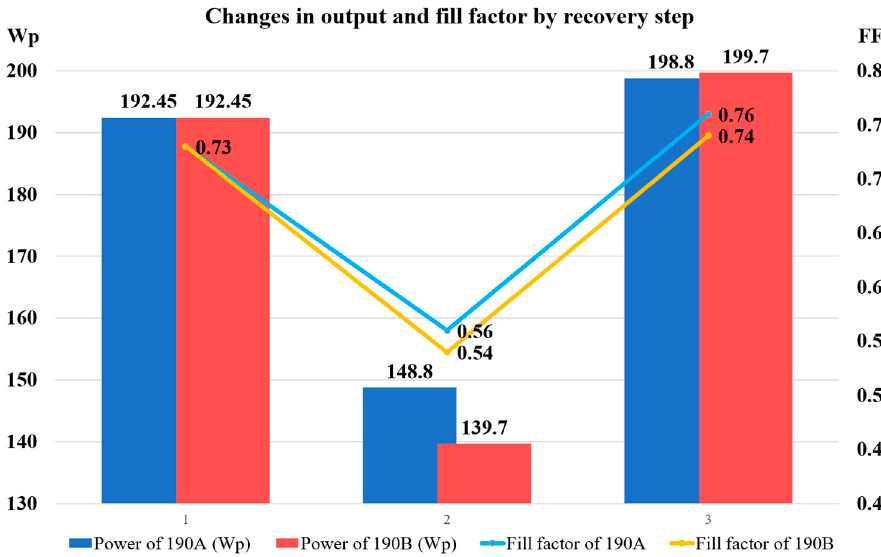
Figure 11. Result of module recovery via cell replacement (power and FF ).